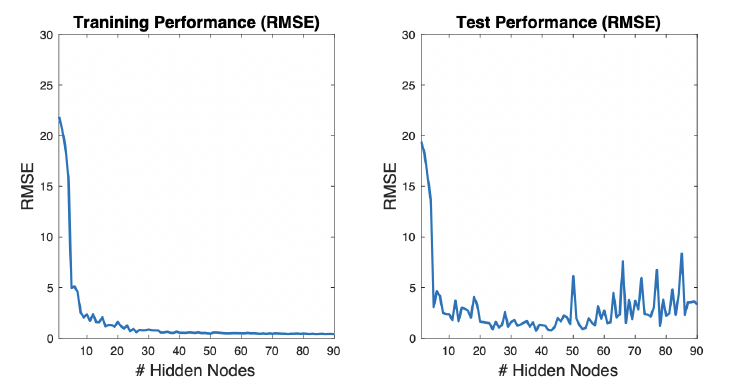
Figure 5. Performance of the model, in terms of the RMSE, for all the turbines of the plant versus the number of hidden nodes, H . On the left, the training results; On the right, the test